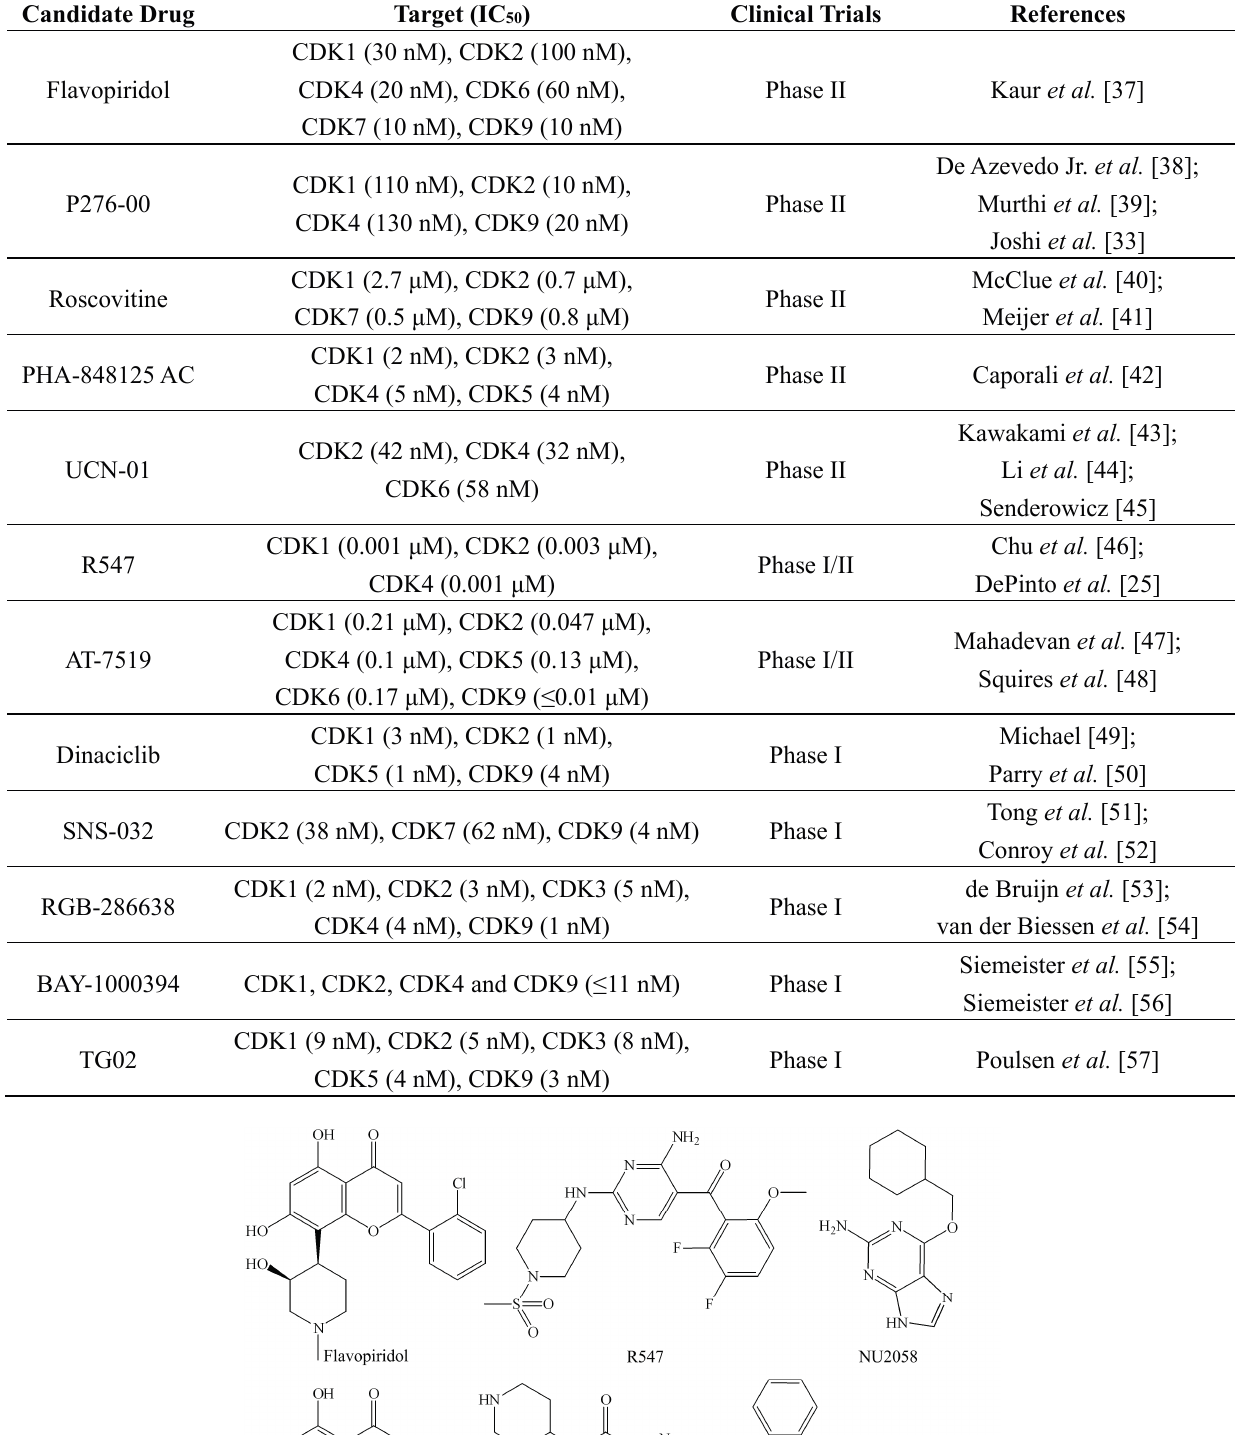
Table 1. CDK2 inhibitors in clinical trials.